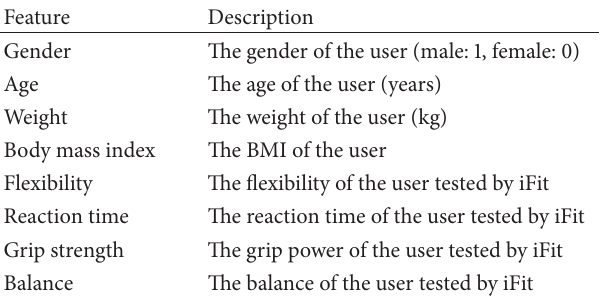
Table 1: Descriptions of